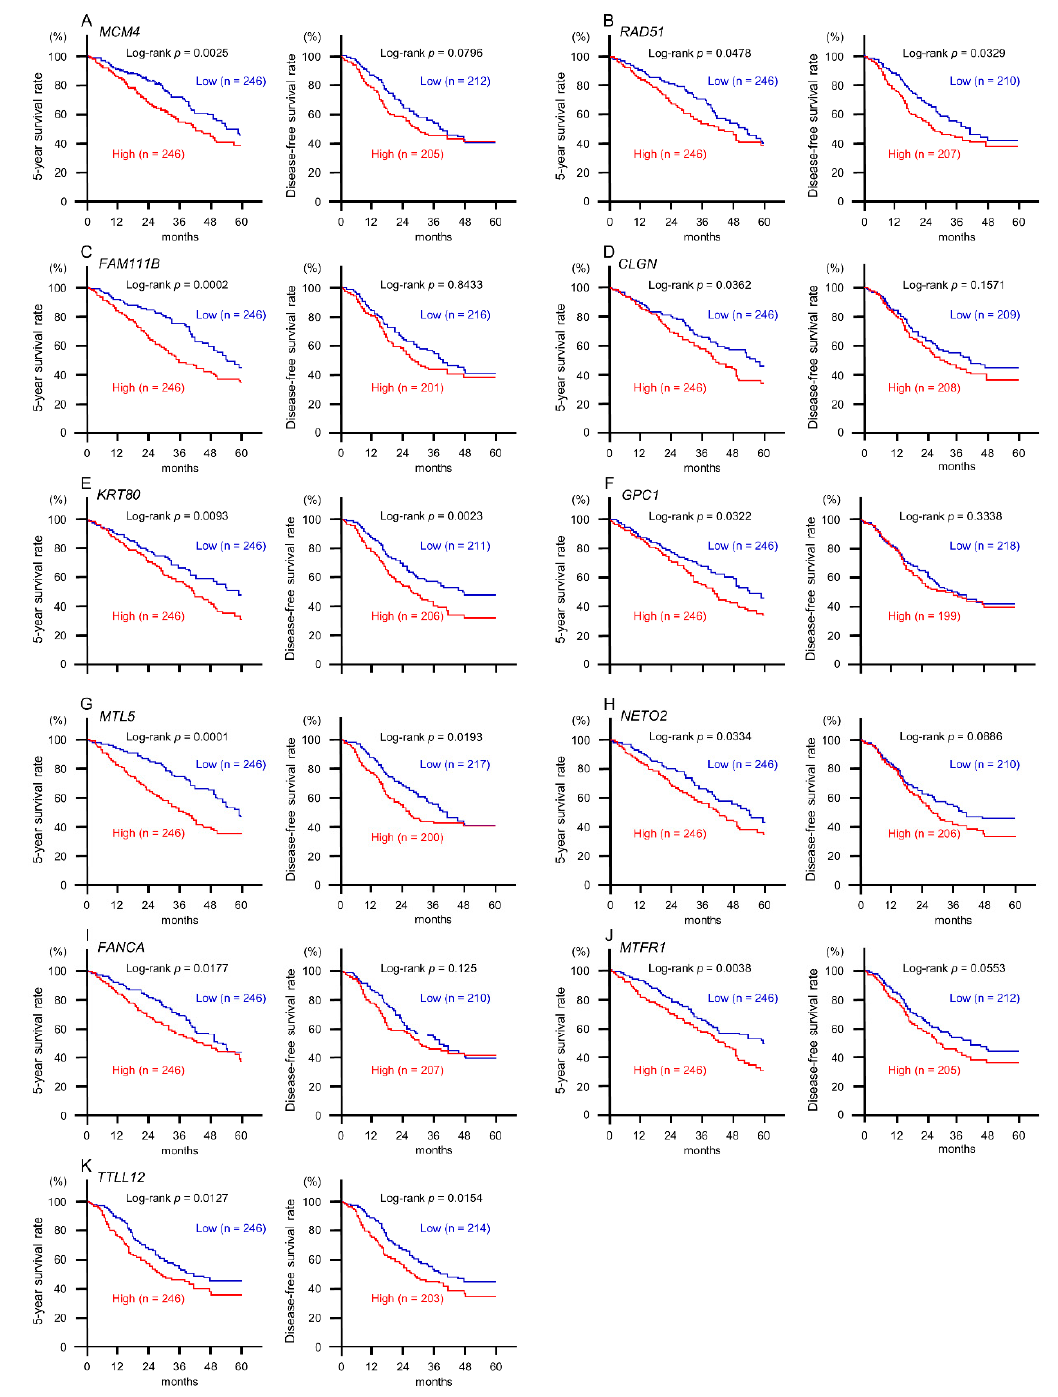
Figure 4. Clinical significance of miR-143-5p target genes in TCGA database. Among putative targets of miR-143-5p in LUAD cells, high expression of 11 genes ( MCM4 , RAD51, FAM111B , CLGN , KRT80 , GPC1 , MTL5 , NETO2 , FACNCA , MTFR1 , and TTLL12 ) was significantly associated with poor prognosis in patients with LUAD. Kaplan–Meier curves of 5-year overall survival and 5-year disease-free survival are shown.